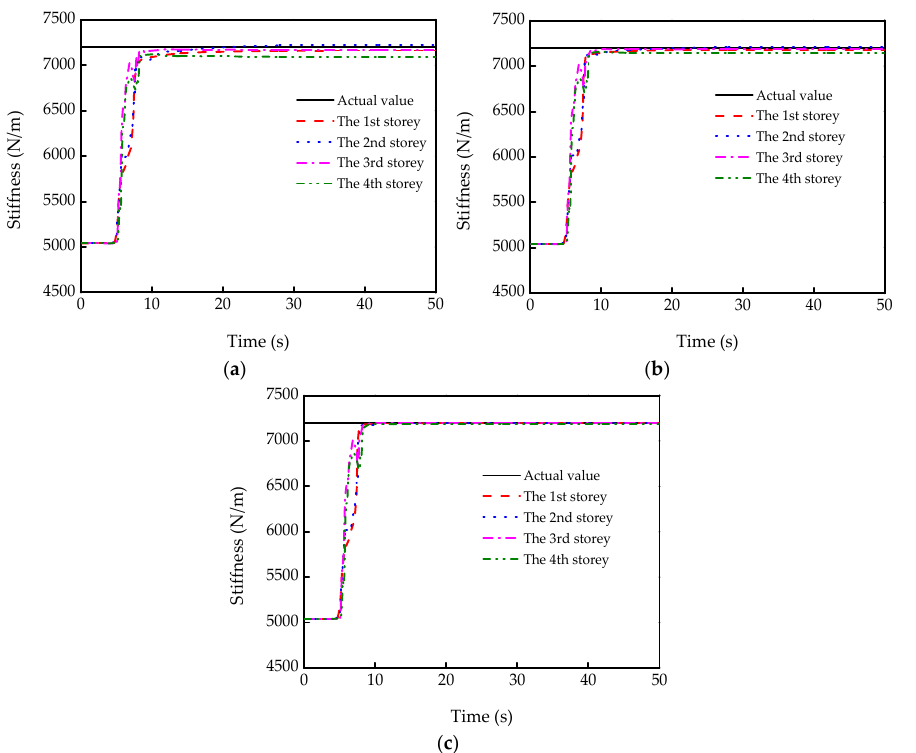
Figure 3. Stiffness estimation by three integration methods: ( a ) rectangular integration; ( b ) trapezoidal integration; ( c ) fourth-order Runge–Kutta integration.